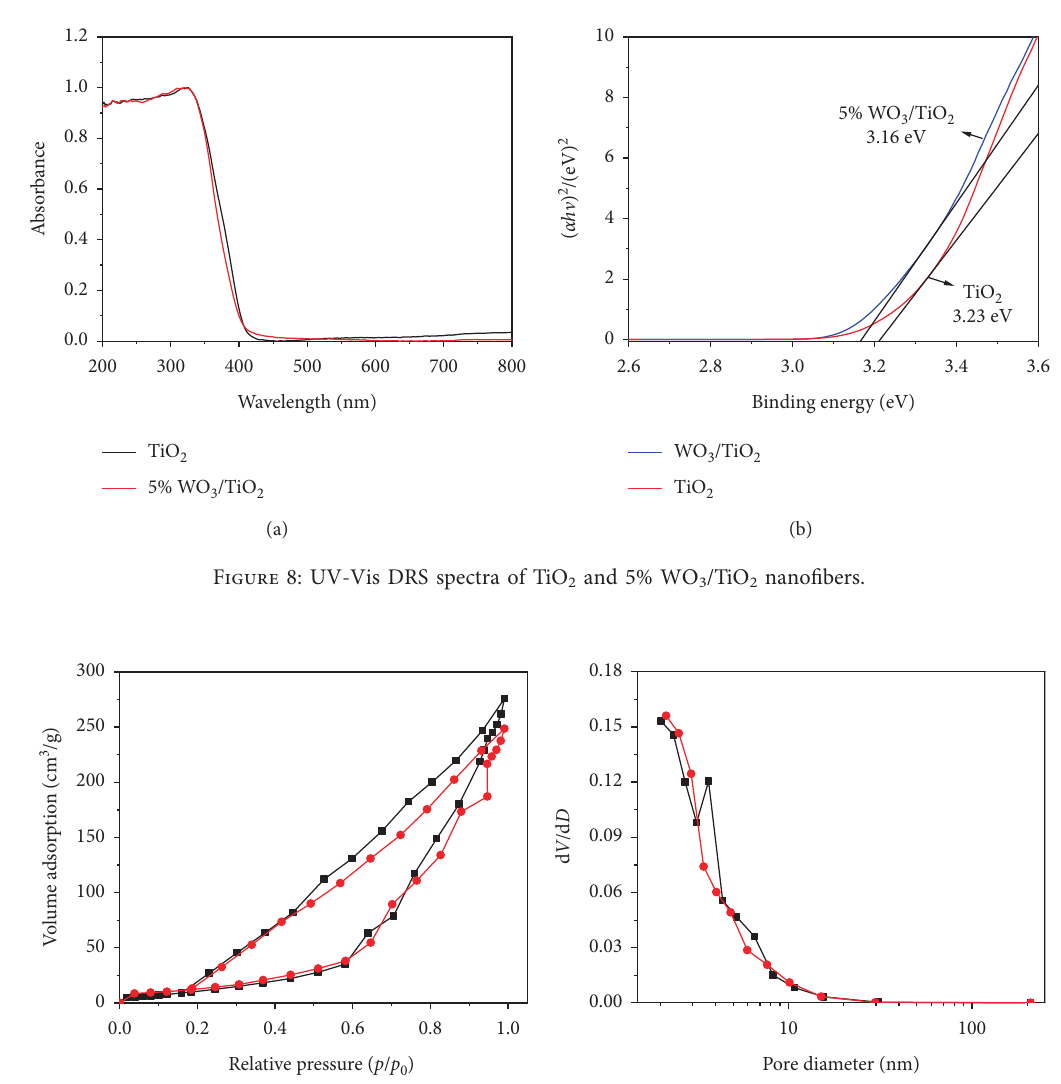
Figure 9: N 2 adsorption and desorption isotherms (a) and the BJH pore size distribution of TiO 2 and 5% WO 3 /TiO 2 nanofibers (b). Table 2: Specific surface area, average pore size, and pore volume of TiO